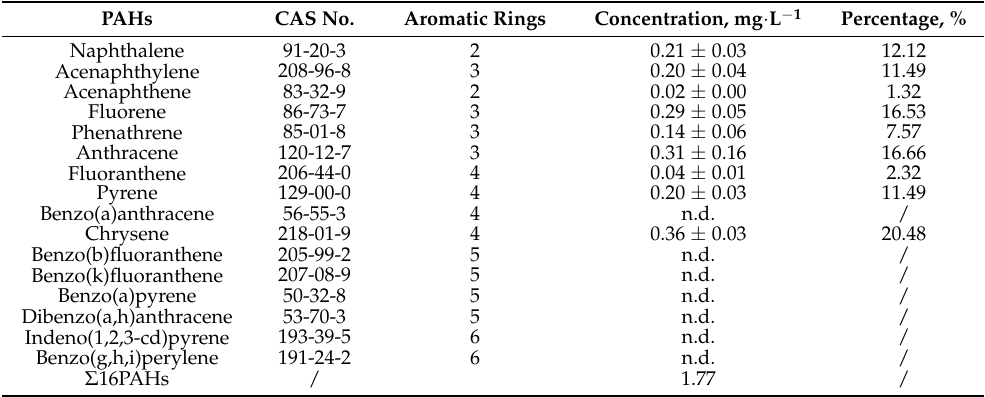
Table 2. Individual and total ( Σ 16PAHs) PAH concentrations analyzed in WAFs ( n =